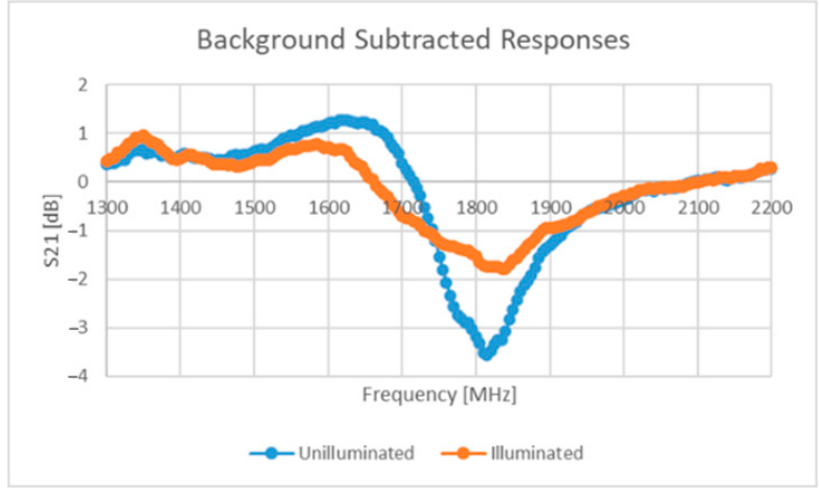
Figure 14. Response from illuminated and unilluminated LDR ‐ loaded ELC tag.